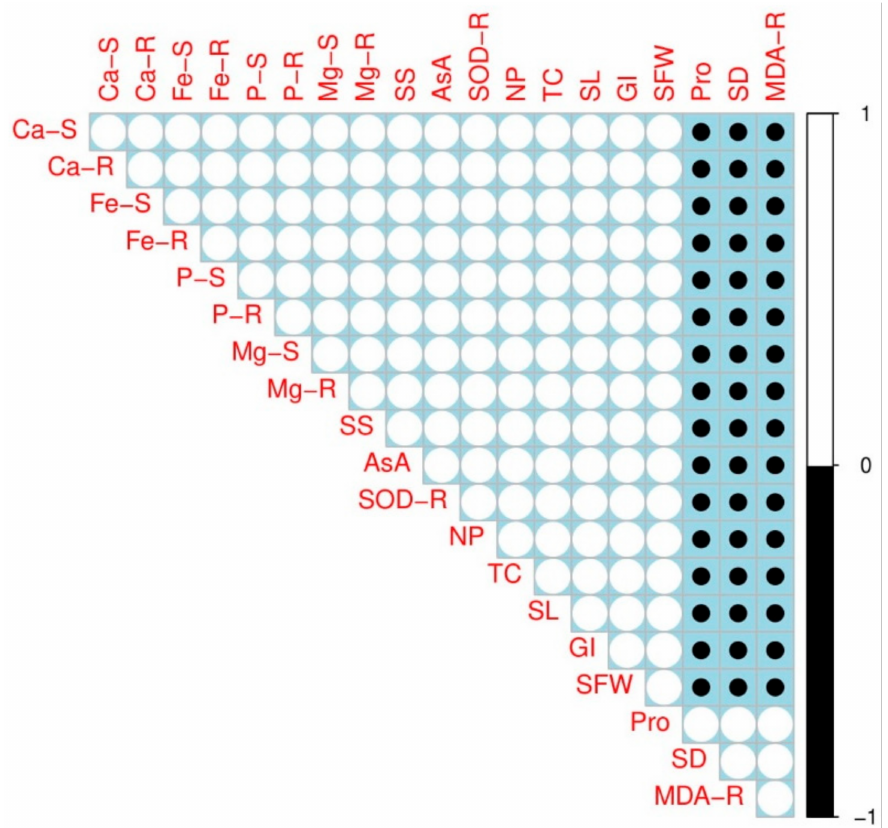
Figure 9. Correlation between different morph-physiological traits with ions uptake/accumulation in different parts of plants. Different abbreviations used are as follow: Ca-S (calcium contents in the shoots), Ca-R (calcium contents in the roots), Fe-S (iron contents in the shoots), Fe-R (iron contents in the roots), P-S (phosphorus contents in the shoots), P-R (phosphorus contents in the roots), Mg- S (magnesium contents in the shoots), Mg-R (magnesium contents in the roots), SS (soluble sugar), AsA (ascorbic acid contents), SOD-R (superoxidase dismutase activity in the roots), NP (net photosyn- thesis), TC (total chlorophyll contents), SL (shoot length), GI (germination index), SFW (shoot fresh weight), Pro (proline contents), SD (stomatal density) and MDA-R (malondialdehyde contents in the